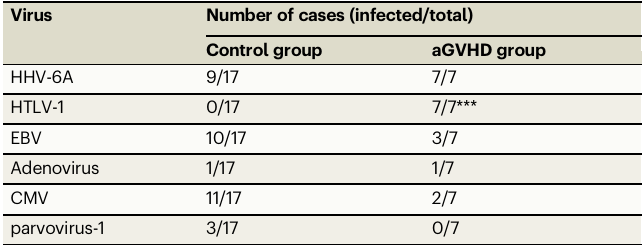
Table 1 | Summary of virus detection results and joint analysis